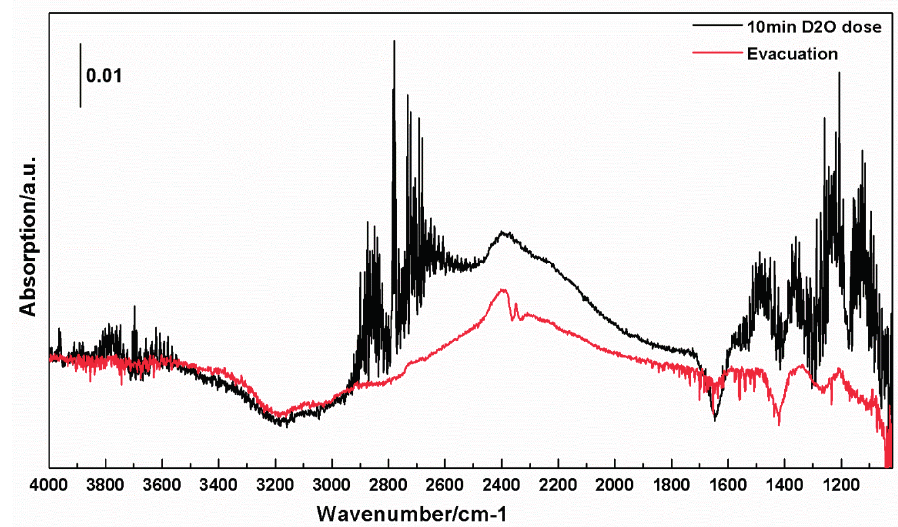
Figure 7. The upper spectrum is the in situ FT-IR spectra of the cTiNT-O 2 -H 2 after exposure to D 2 O vapor for 10 min at room temperature. The lower spectrum is of the same sample after exposure to vacuum at room temperature. The background for these spectra is the c-TiNT-O 2 -H 2 s.